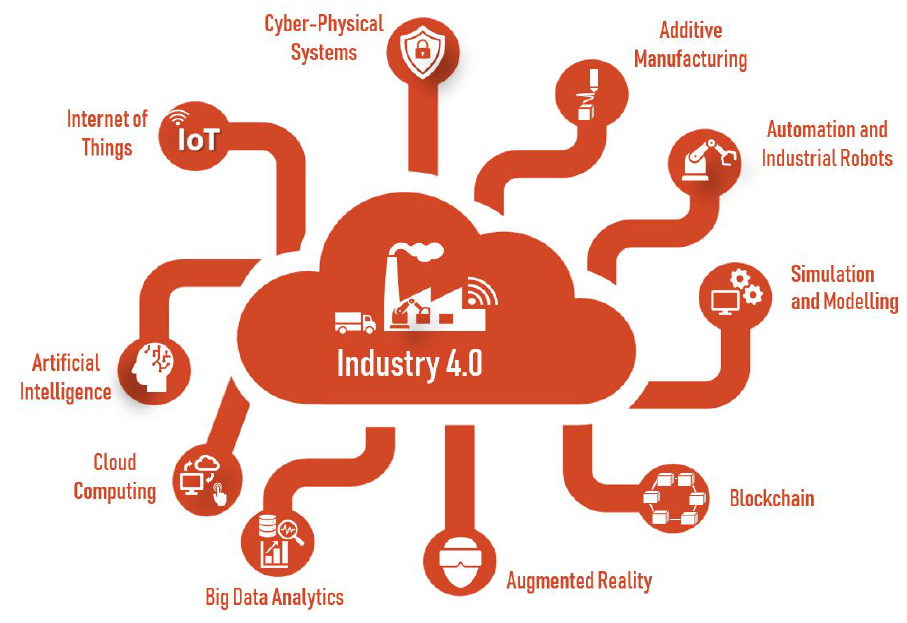
Figure 1. Pillars of Industry